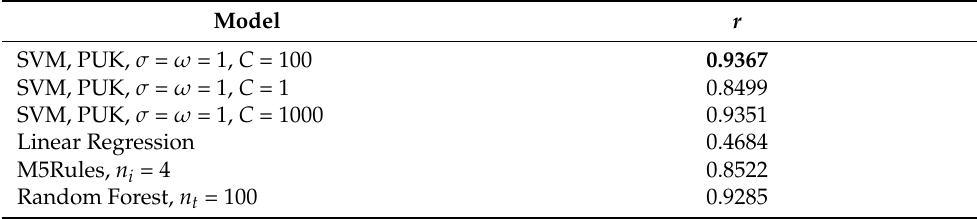
Table 4. Cross-validation results for color removal/discoloration (without pH influence).